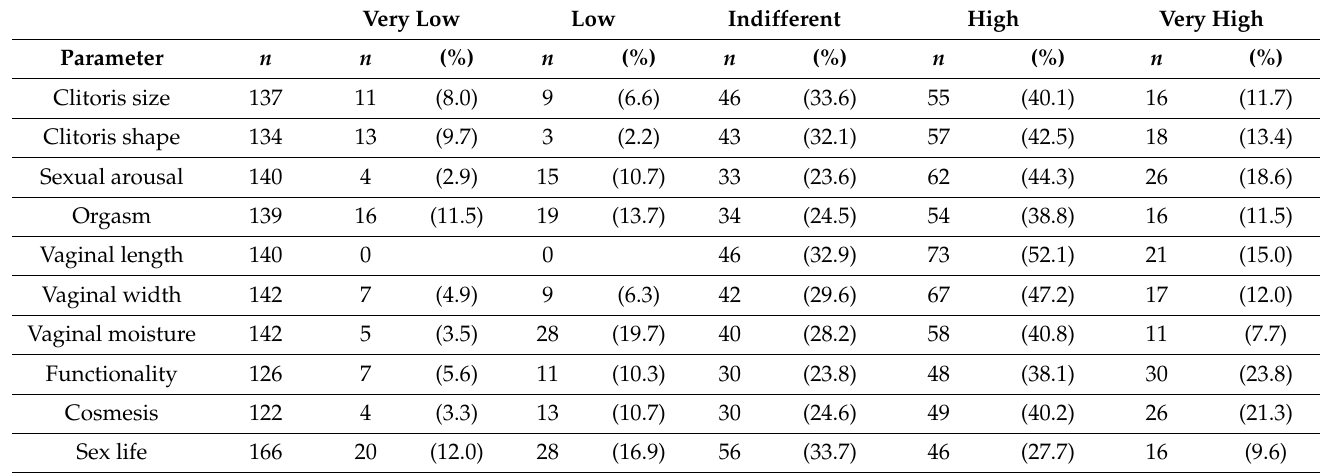
Table 6. Satisfaction with their genitals in women with